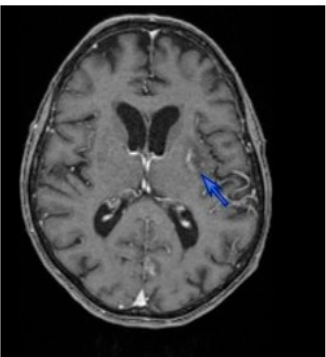
Figure 1. Computer tomography (CT) brain showing a 23 nm lenticular lesion in the left basal ganglia (blue arrow).